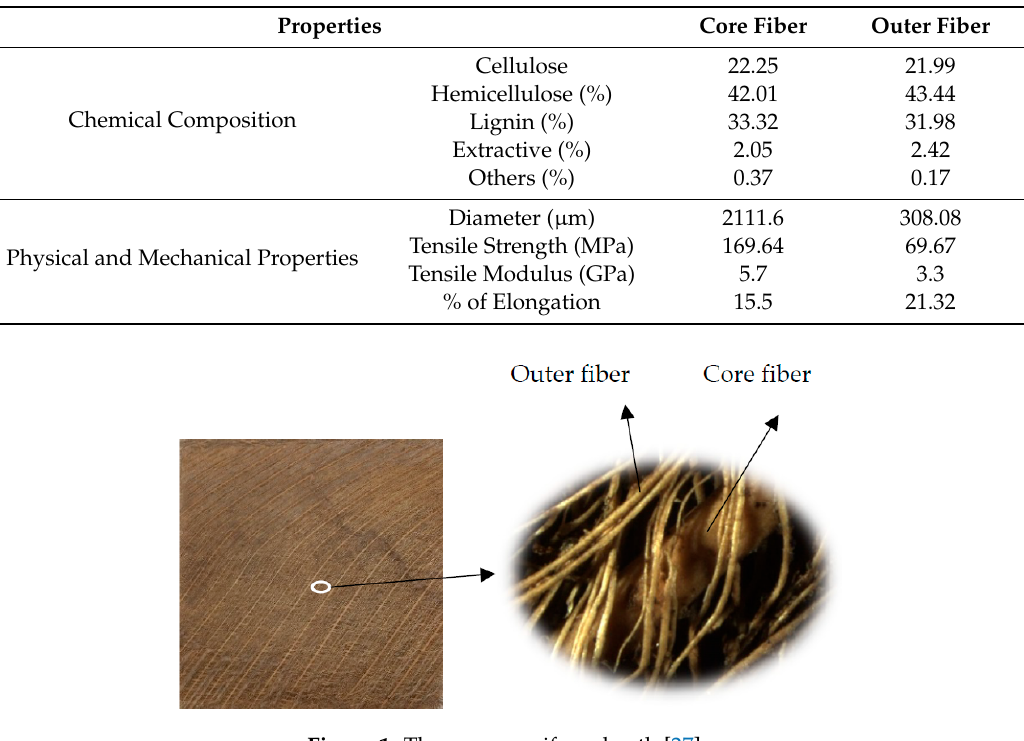
Figure 1. The cocos nucifera sheath [27]. Table 1. The properties of the core and outer fiber of the cocos nucifera sheath [27].